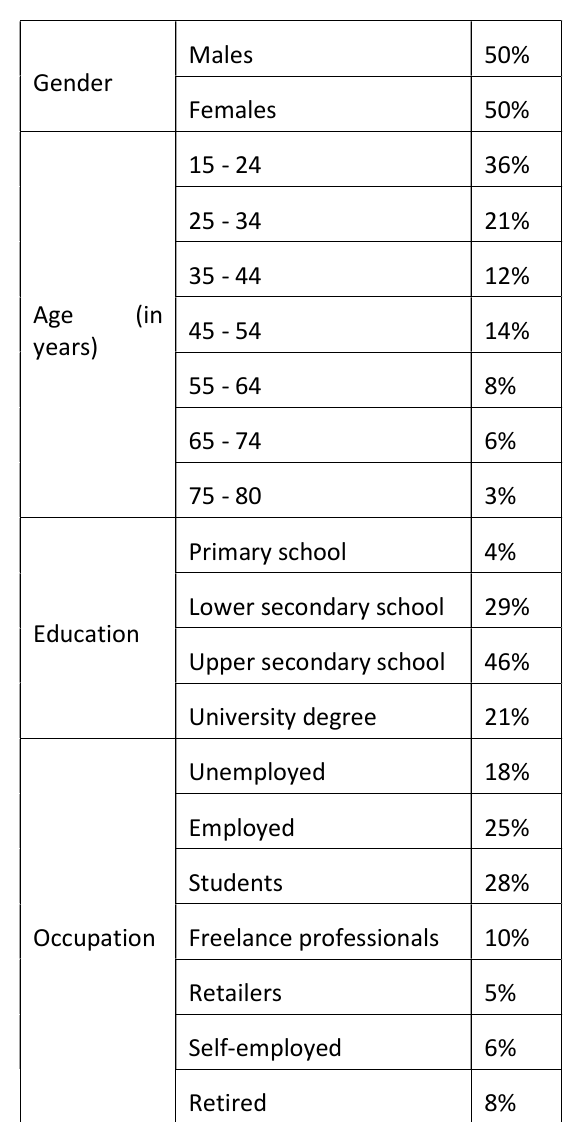
Table 1: Socio-demographic characteristics of the